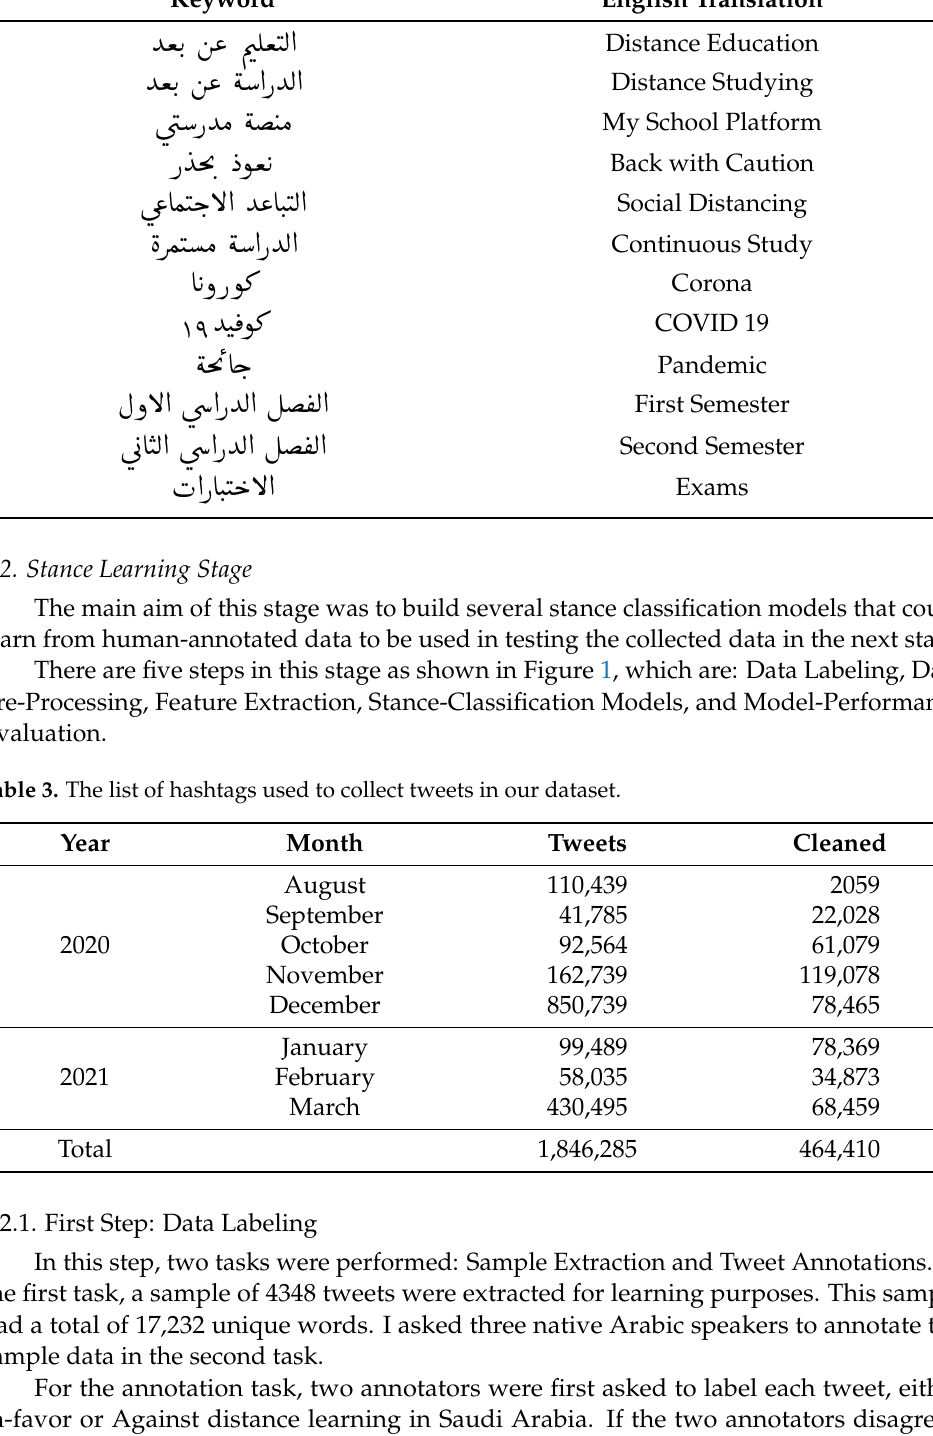
Table 2. The list of keyword used in hashtags to collect tweets in my dataset. Keyword English Translation